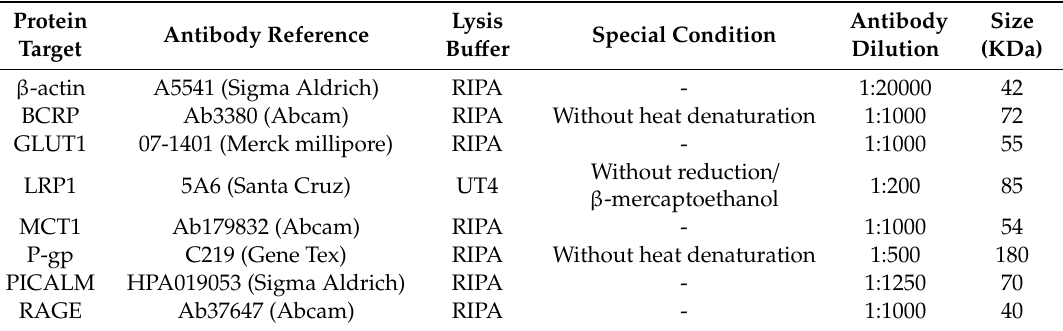
Table 2. Antibodies used for the Western blot